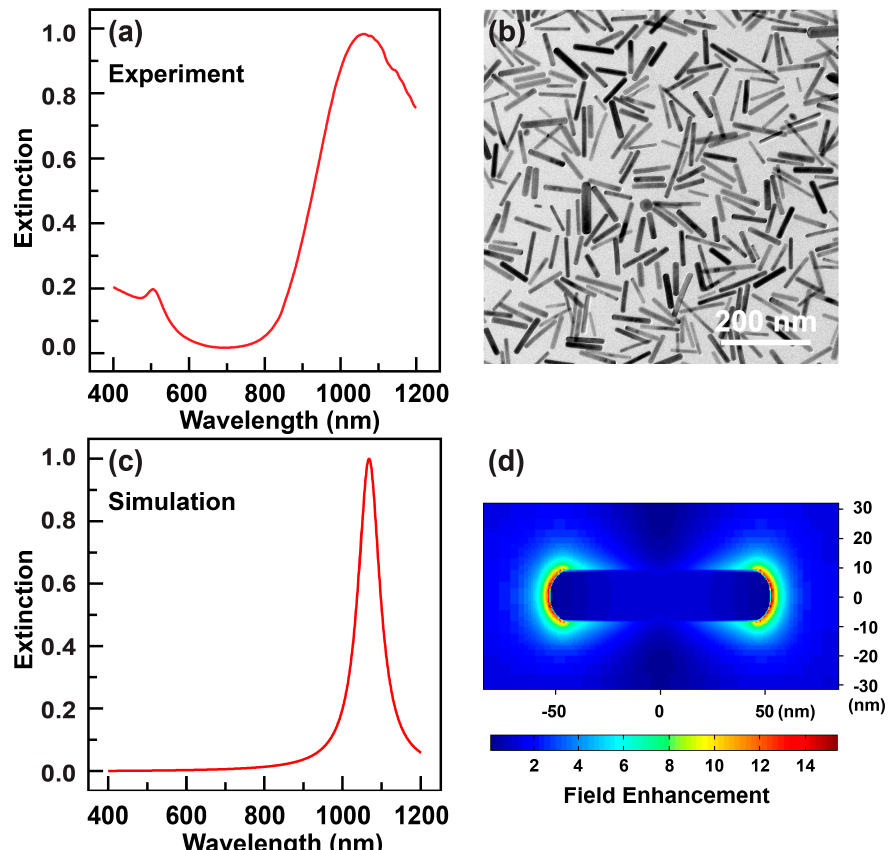
Figure 1. Characterizations of the gold nanorods of large aspect ratios. ( a ) Experimental extinction spectrum of the gold nanorod aqueous solution. ( b ) TEM image of a typical gold nanorod sample. ( c ) Calculated extinction spectrum of an individual gold nanorod. The geometrical parameters of the nanorod are set according to those measured from the image shown in Figure 1b. ( d ) Calculated near-field electromagnetic distributions around the individual gold nanorod. The electric fields are monitored at the extinction maximum shown in Figure 1c, and on the plane across the longitudinal axis of the nanorod.